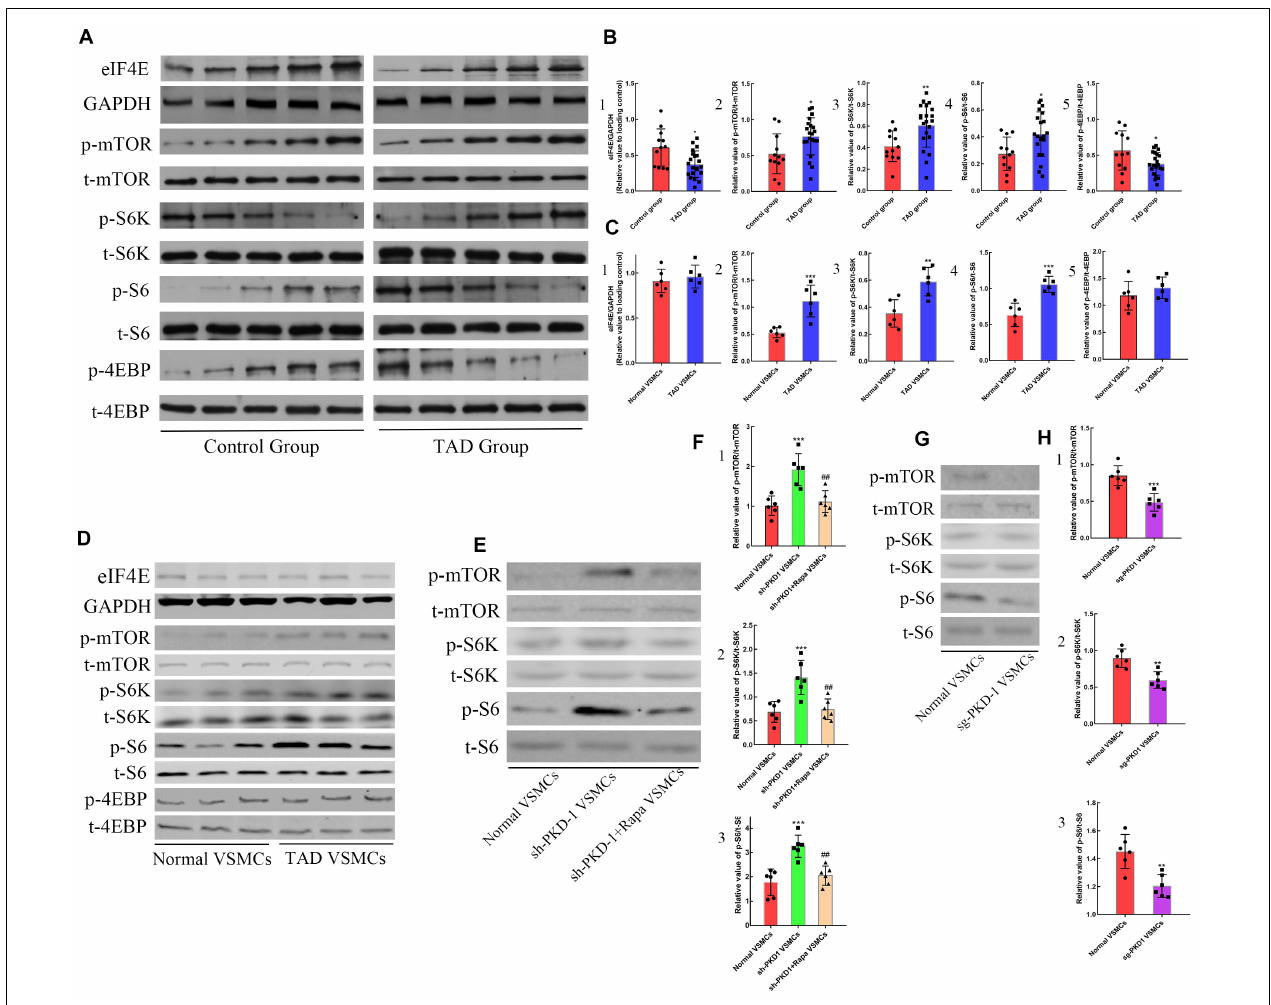
FIGURE 5 | The effects of PC-1 expression on the signaling pathway in human samples and VSMCs. Increased expression of (A,B1) eIF4E ( p = 0.0128) as well as phosphorylation of (A,B2) mTOR ( p = 0.0159), (A,B3) S6K ( p = 0.0066), (A,B4) S6 ( p = 0.0126) and (A,B5) 4EBP ( p = 0.0189) in TAD group compared with control group. (C2–4,D) The phosphorylation of mTOR ( p = 0.0009), S6K ( p = 0.0029) and S6 ( p = 0.0004) were elevated in TAD VSMCs, but the phosphorylation of (C1,D) 4EBP and expression of (C5,D) eIF4E were not altered. The phosphorylation of (E,F1) mTOR ( p = 0.0003), (E,F2) S6K ( p = 0.0007) and (E,F3) S6 ( p = 0.0001) was enhanced in sh-PKD-1 VSMCs compared with normal VSMCs. The phosphorylation of (E,F1) mTOR ( p = 0.0022), (E,F2) S6K ( p = 0.003) and (E,F3) S6 ( p = 0.0006) were inhibited in sh-PKD-1 + Rapa VSMCs compared with sh-PKD-1 VSMCs. The phosphorylation of (G,H1) mTOR ( p = 0.0006), (G,H2) S6K ( p = 0.0015) and (G,H3) S6 ( p = 0.002) were decreased in sg-PKD-1 VSMCs compared with the control group. ## p < 0.01, * p < 0.05, ** p < 0.01, *** p <